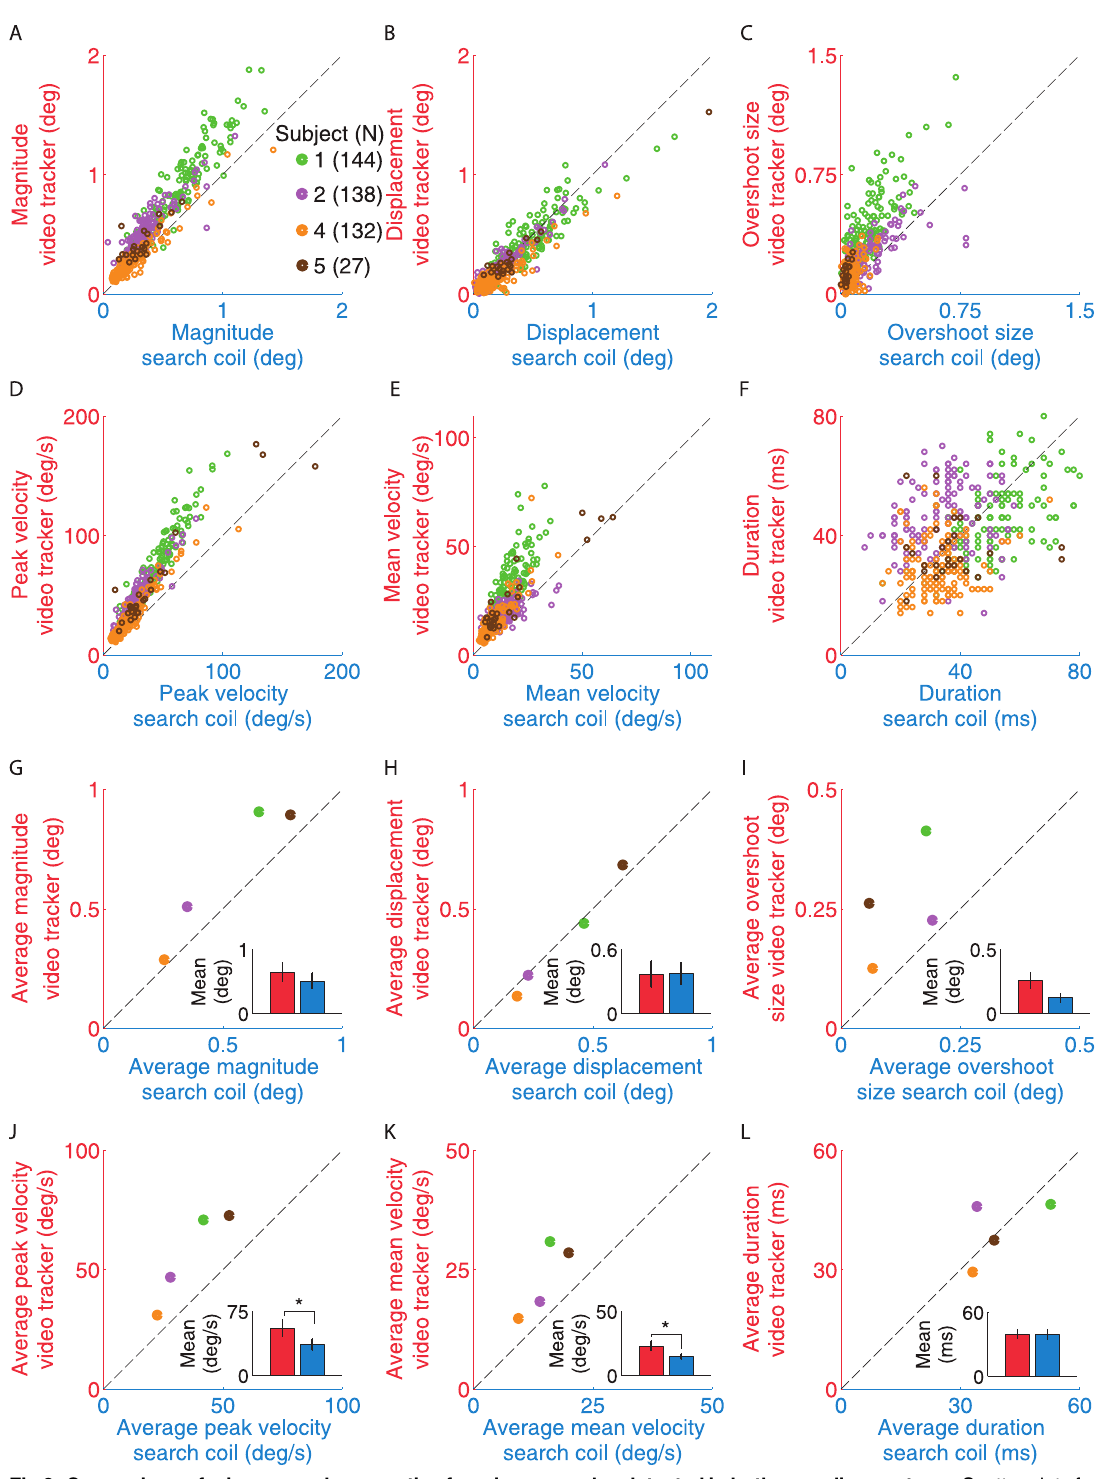
PLOS ONE | DOI:10.1371/journal.pone.0128428 June 2, 2015 11 /